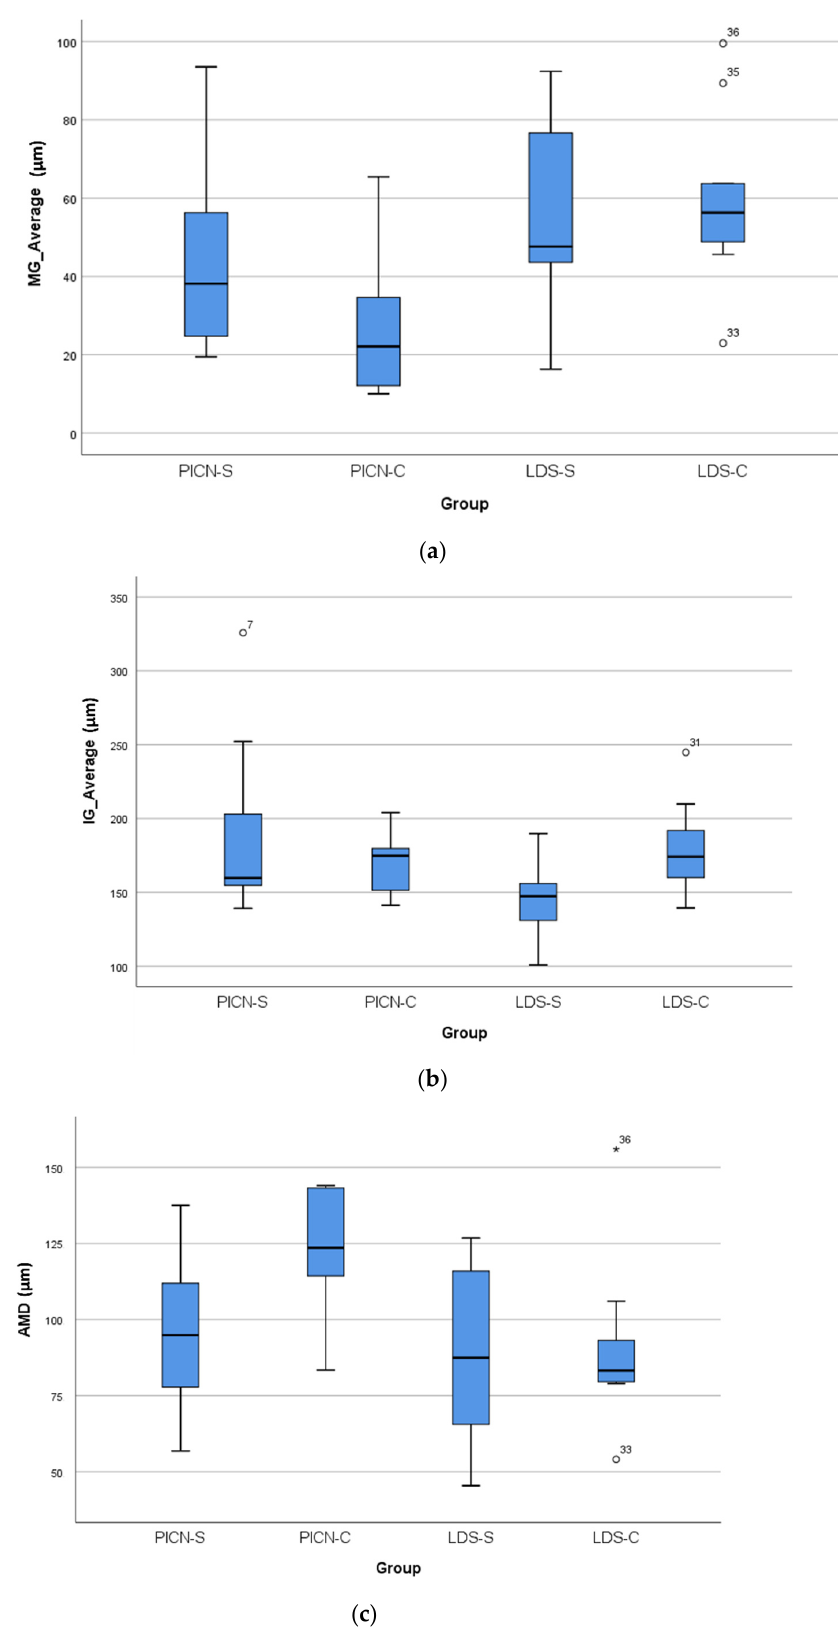
Figure 8. Box plot graphs showing the distribution of minimum, first quartile, median, third quartile, and maximum MG ( a ), IG ( b ), and AMD ( c ) values for each crown material–finish line group. Circles denote outliers with the test sample numbers displayed.